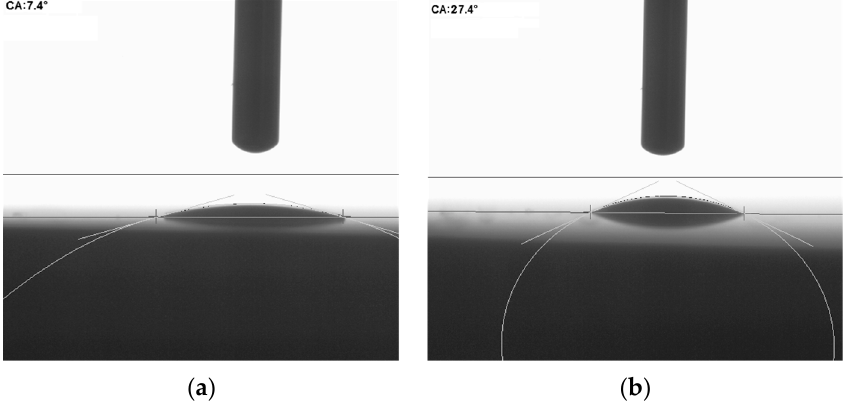
Figure 2. The value of the wetting angle of the KBr crystal before ( a ) and after ( b ) the nanostructuring process.